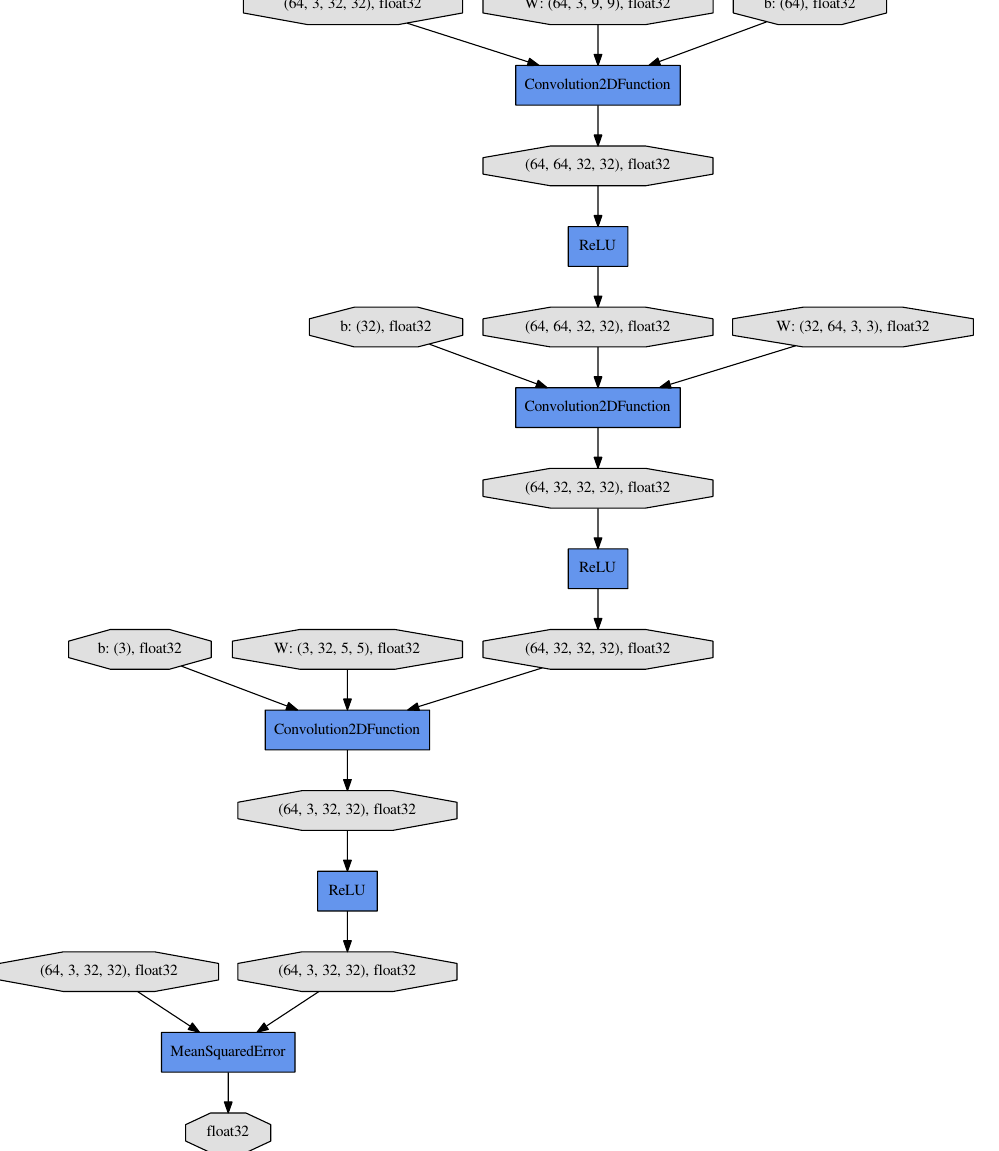
Figure 1. Architecture of the SRCNN